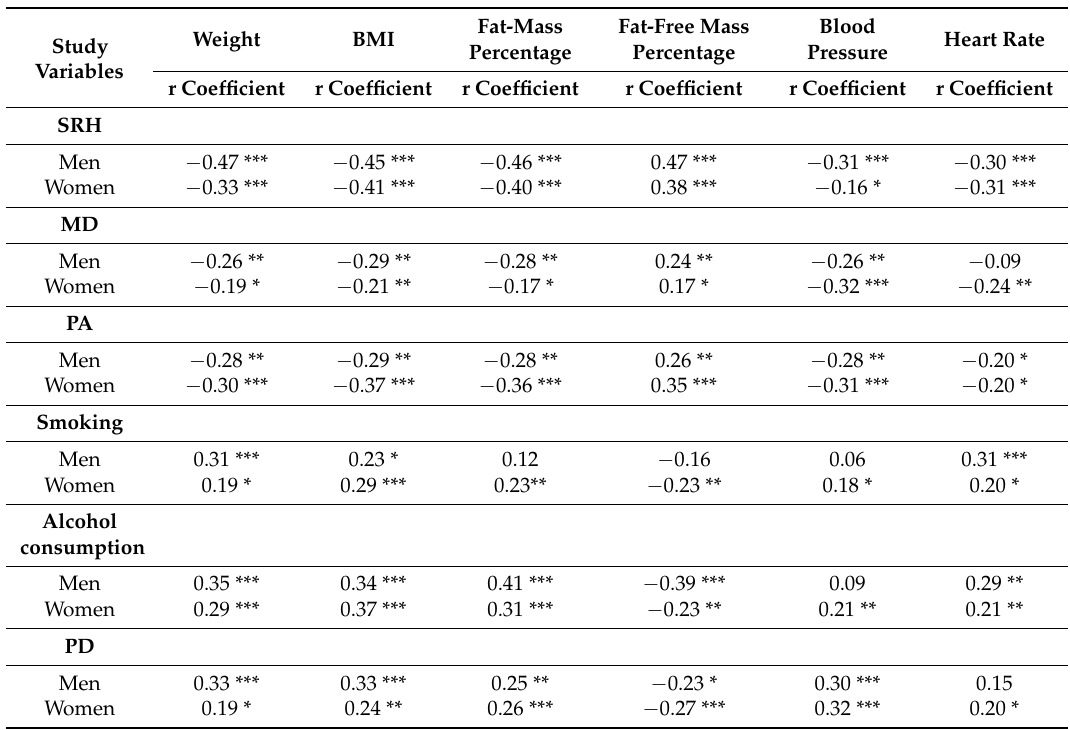
Table 2. The relationship between the lifestyle factors and body composition parameters, stratified by